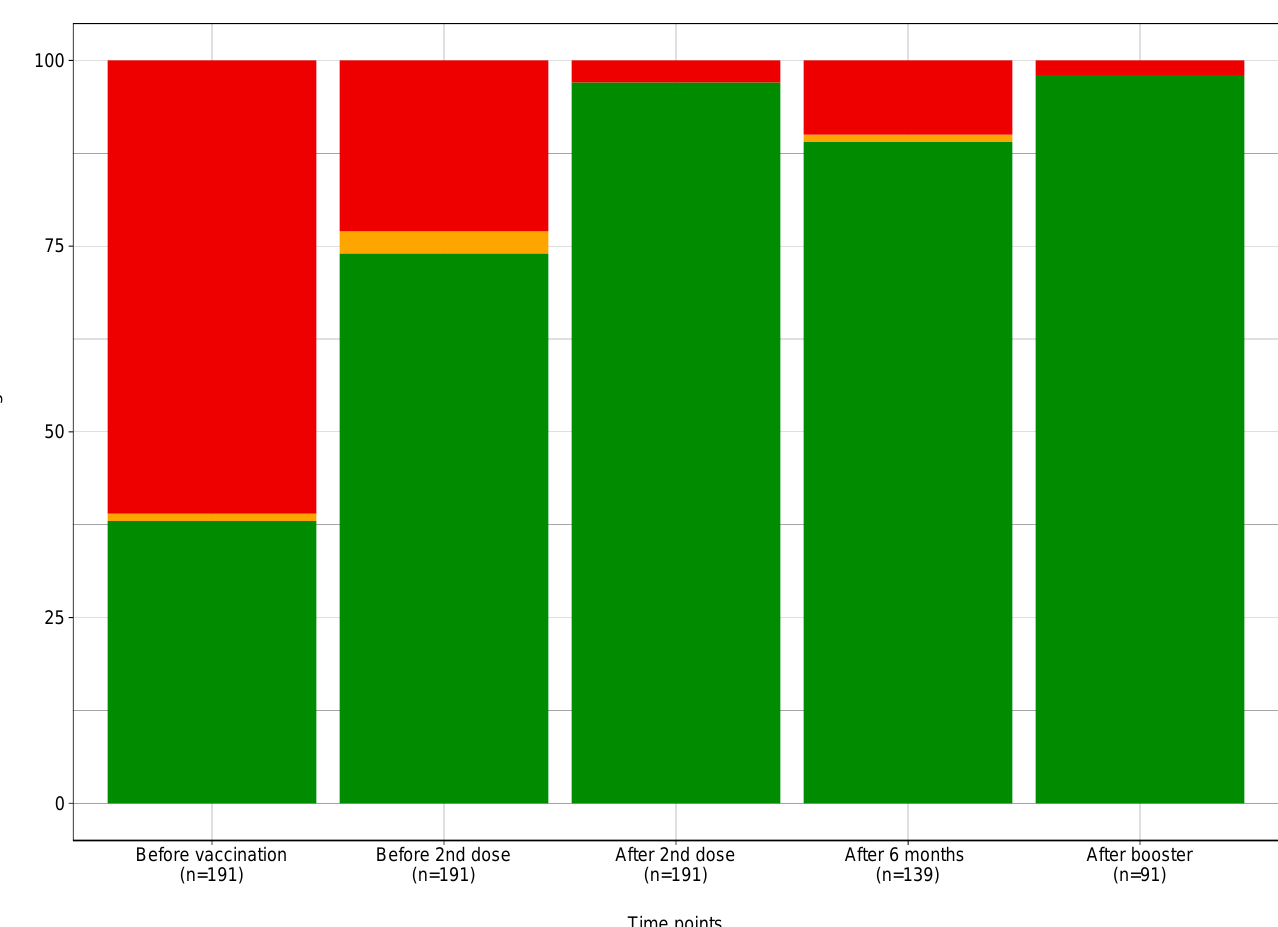
Figure 2. Humoral response after subsequent vaccine doses (red color: non-responders, orange: borderline response, green: adequate response).